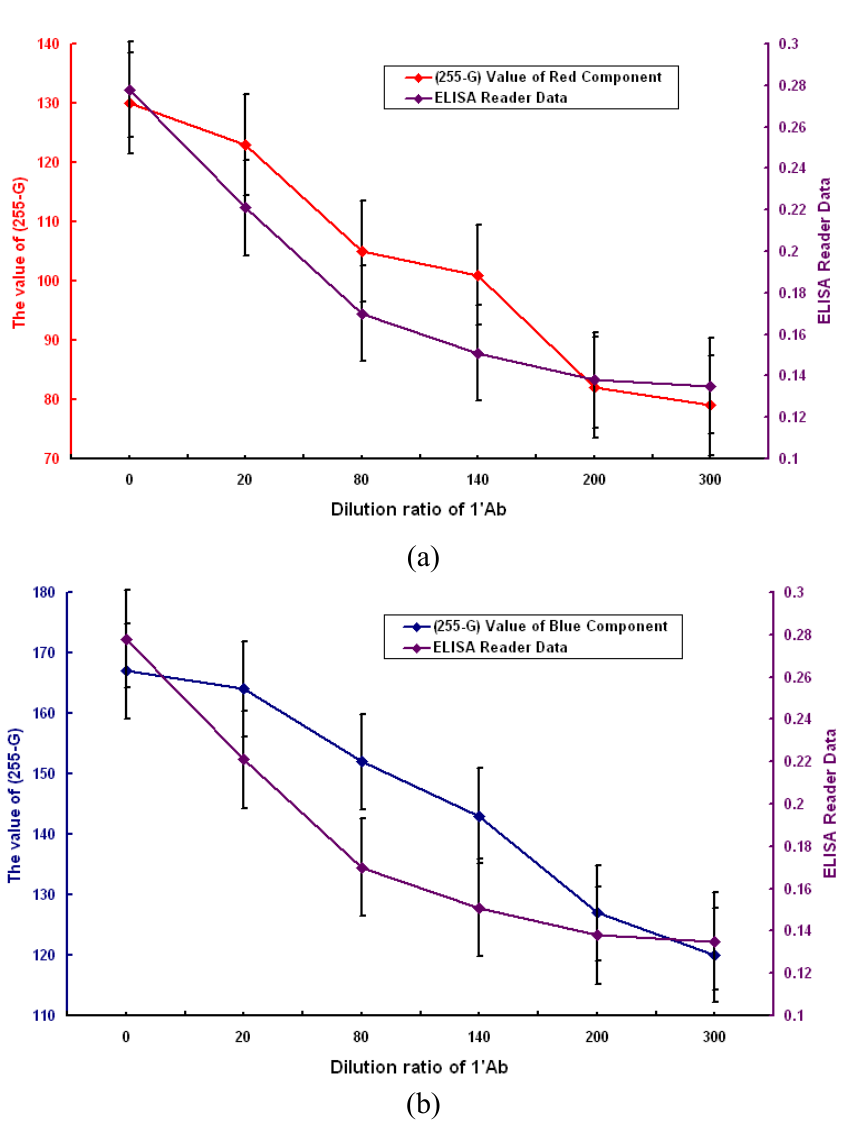
Figure 11. Results and comparison of the (255-G) value of images and ELISA reader